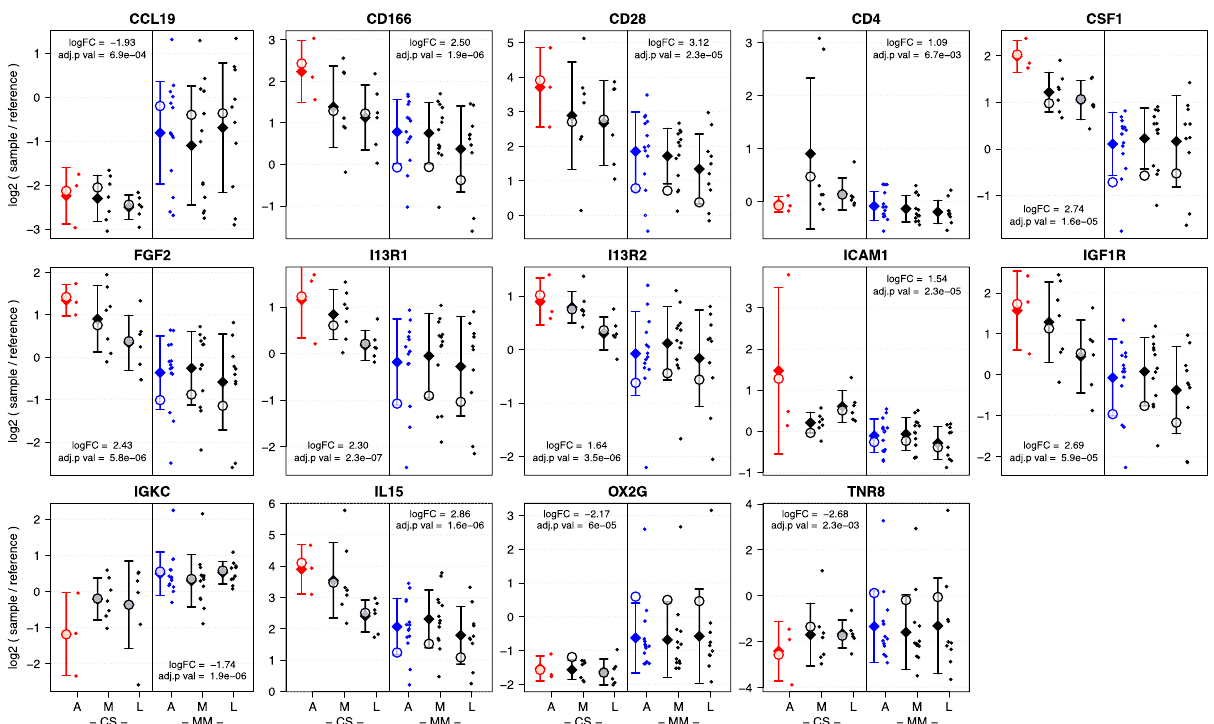
Fig. 3 Stripcharts representing individual array values for all proteins selected as top candidates in the 1 st cohort. Each protein is measured by four replicate spots per array and is represented by their mean. The y-axis illustrates the log2 ratio of the individual samples and a reference sample while the x-axis is divided based on clinical course of disease of the patient (CS and MM) as well as phase of infection. 53 plasma samples from 16 COVID-19 patients were analyzed and divided into an acute (A) an intermediate (M) and a late stage (L), for which we included 18, 20 and 16 samples, respectively. Acute CS and MM samples are highlighted in red and blue respectively. Diamonds indicate arithmetic sample group means. Whiskers indicate one standard deviation, calculated based on arithmetic means. Empty circles indicate the group coef fi cients fi tted by the linear model with additional factors sex, age and comorbidities, which were used for logFC and p value